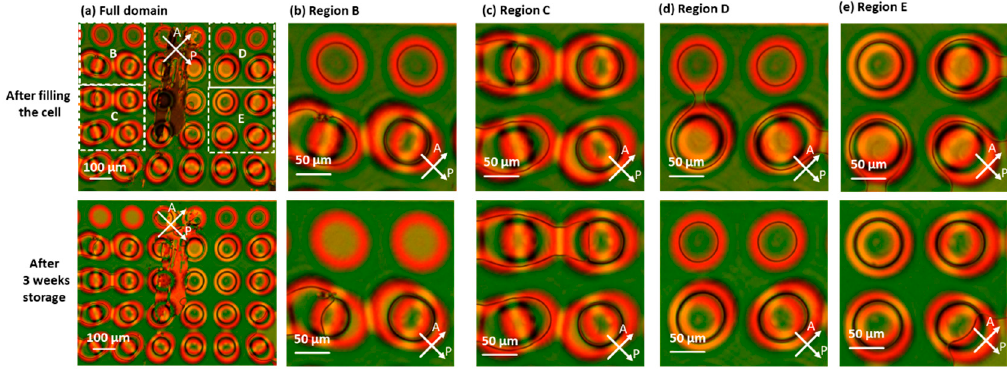
Figure 3. Similar to Figure 2, except for the crossed polarizers that are rotated over 45° with respect to the x- and y-axis.